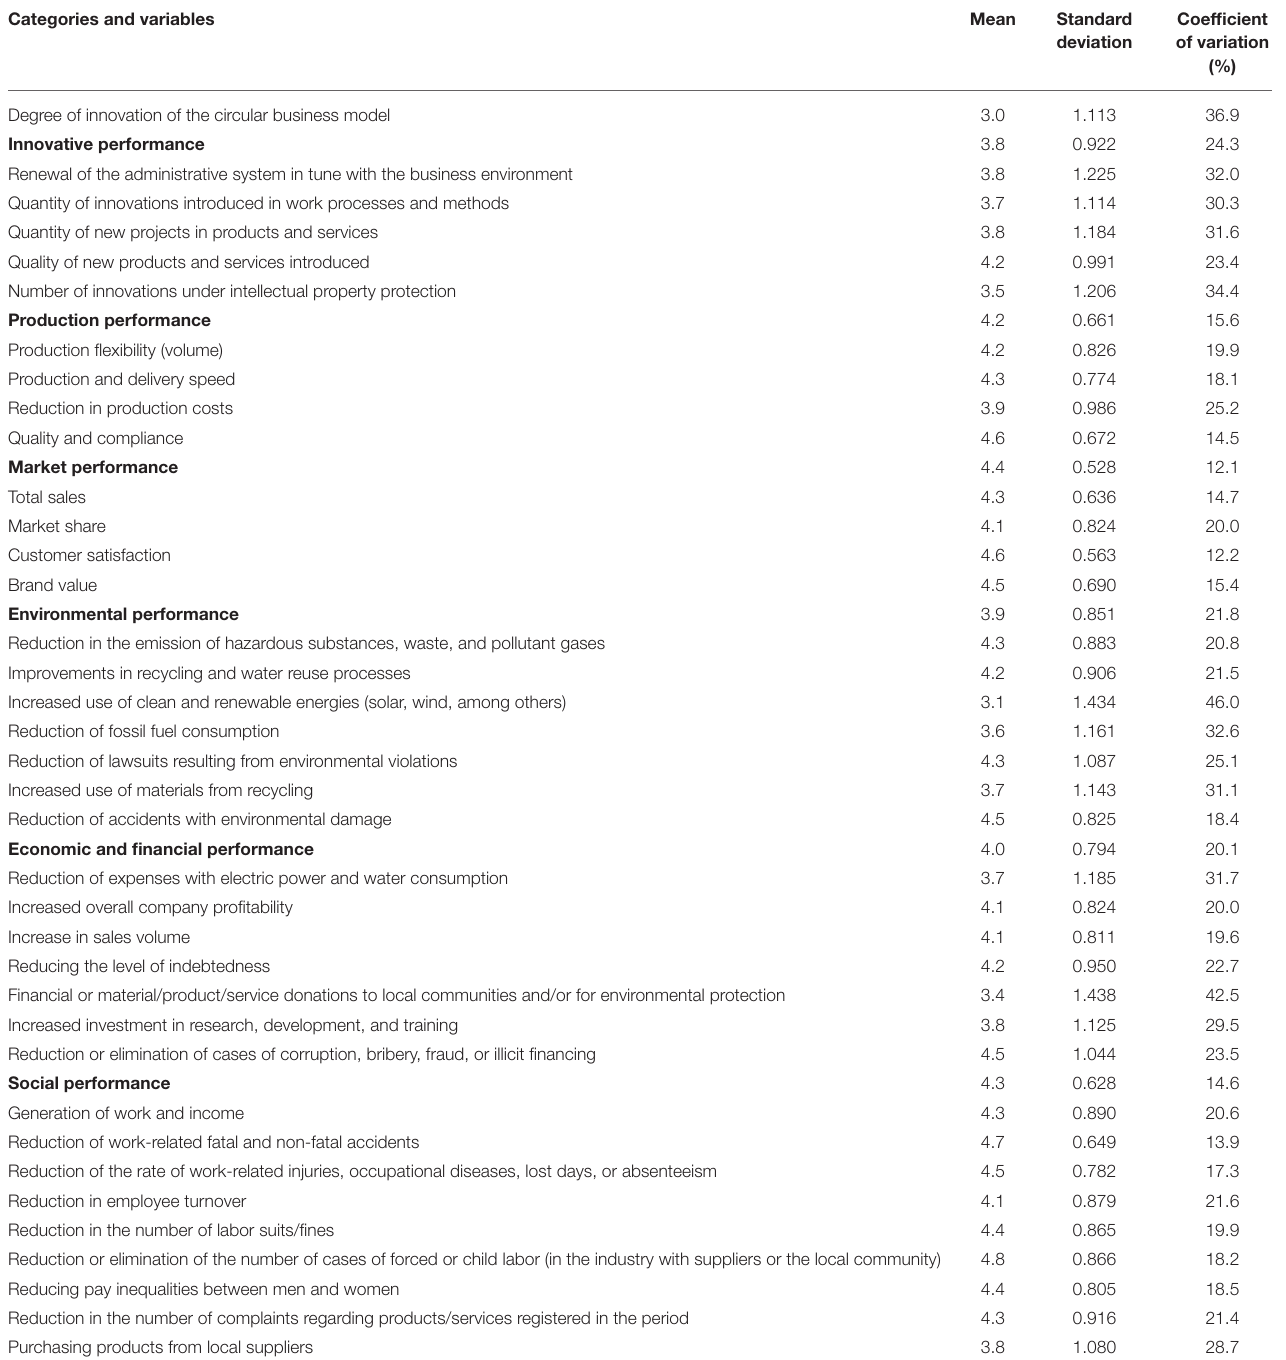
TABLE 2 | Descriptive analysis of categories and